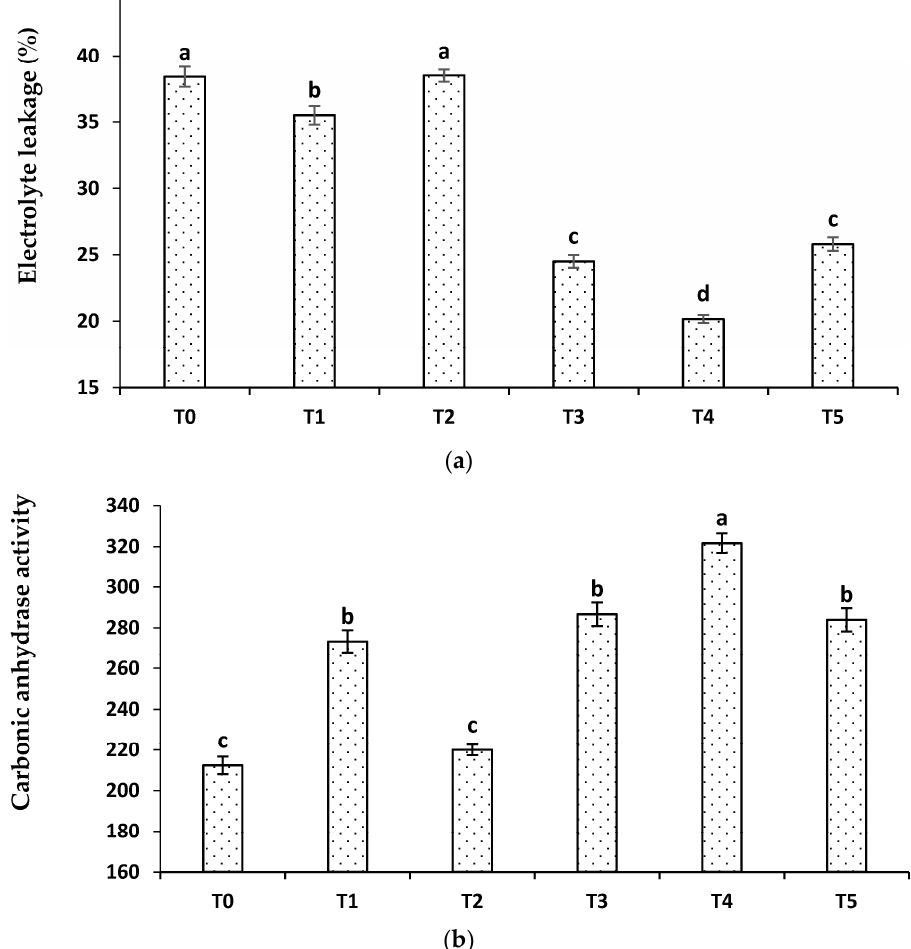
Figure 3. Comparative effectiveness of different Zn formulations of urea regarding electrolyte leakage and carbonic anhydrase activity of wheat: ( a ) = Electrolyte leakage (%) and ( b ) = carbonic anhydrase activity. Treatments are as, T 0 = No Zn; T 1 = recommended Zn (ZnSO 4 ); T 2 = ZSB; T 3 = 1.5% Zn coated urea (ZnO); T 4 = 1.5% bio-activated Zn coated urea (ZnO); and T 5 = 1.5% Zn blended urea (ZnO). Means sharing the same letters do not differ significantly ( p < 0.05).